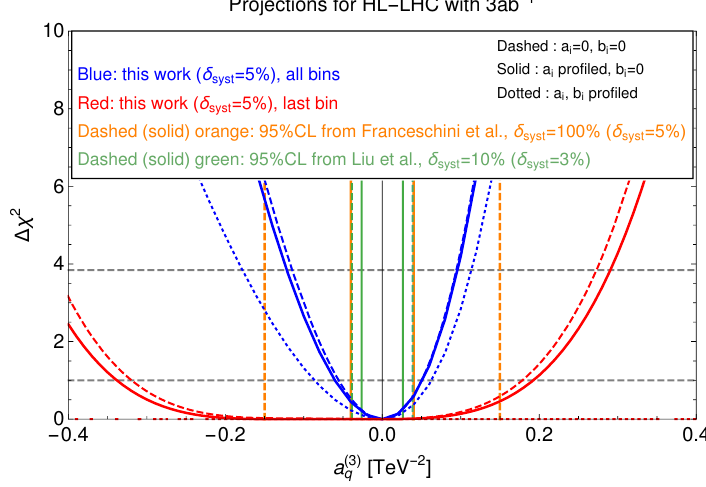
Figure 16 . (cid:31) 2 for a (3) q (cid:11)rom the HL-LHC projections and comparison with the 95% bounds obtained in refs. [12,